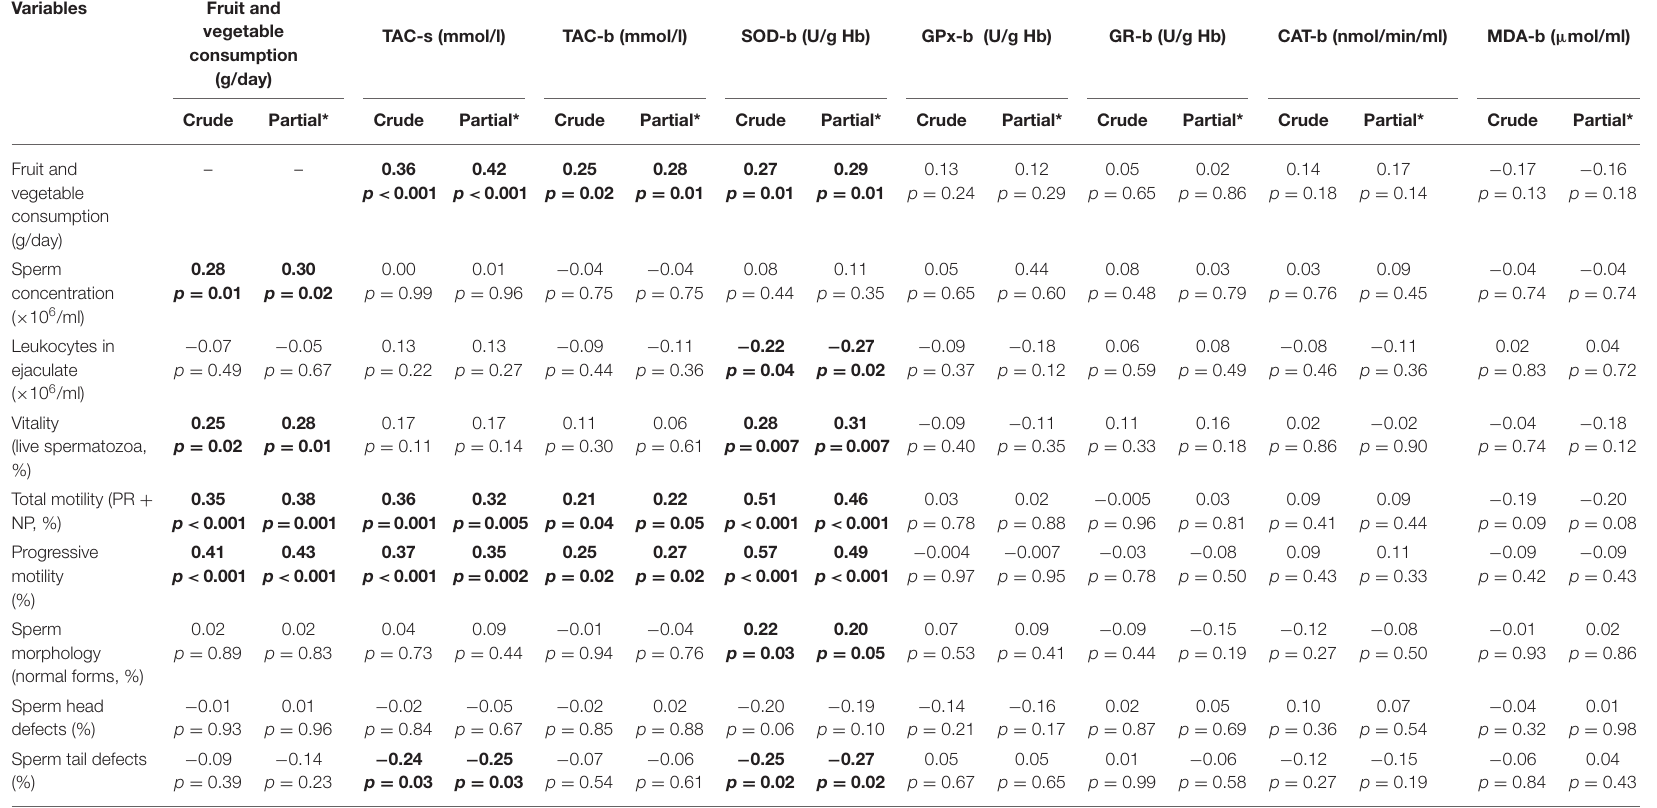
TABLE 4 | Pearson correlation coefficients between fruit and vegetable consumption, antioxidant status and selected semen quality parameters (r, p ).